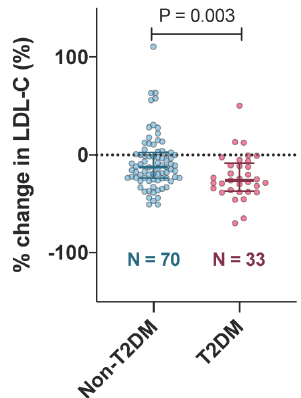
Figure 2. Lipid profiles before and after treatment of ezetimibe in non-T2DM and T2DM groups. Values are mean ± SD or median (25%, 75%). HDL-C, high-density lipoprotein cholesterol; LDL-C, low-density lipoprotein cholesterol; TG, triglyceride; T2DM, type 2 diabetes mellitus. * p < 0.05; ** p < 0.01 vs. non-T2DM. p values vs. baseline. ns: not significant.